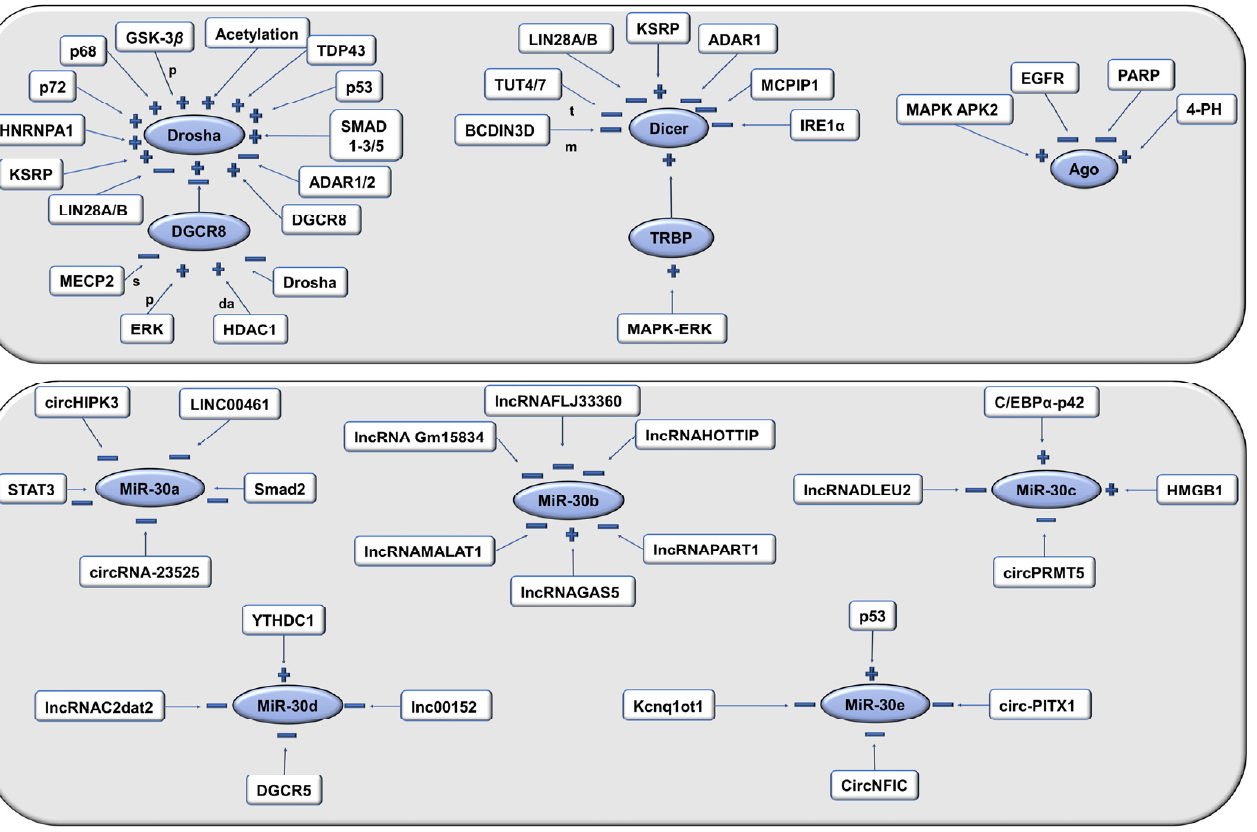
Figure 4. Regulation of miR-30 by ( A ) transcriptional and ( B ) post-transcriptional mechanisms. Drosha negatively regulates the expression of DGCR8 mRNA whereas DGCR8 positively upregu- lates the stability of Drosha, thereby maintaining a homeostatic balance. A positive sign represents an increase in pri- or pre-miR processing by positive regulation (increase in the stability and nuclear localization) of Drosha, Dicer, or Ago. A negative sign represents a decrease in pri- or pre-miR pro- cessing. ADAR 1/2: adenosine deaminases, da: deacetylation, GSK-3 β : glycogen synthase kinase 3 β , HDAC1: histone deacetylase 1, HNRNPA1: heterogeneous nuclear ribonucleoprotein A1, KSRP: KH-type splicing regulatory protein, m: methylation, MCPIP1: MCP-induced protein 1, MECP2: methyl-CpG-binding protein 2, s: sequestration, t: miR tailing via untemplated nucleotidyl accumu- lation to the 3 ′ end of RNA, TDP43: TAR DNA-binding protein 43, TUT 4/7: terminal uridylyl trans-